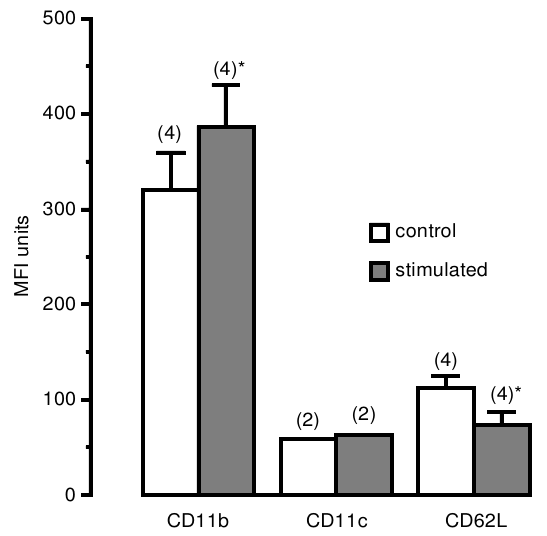
Table 1. Effect of DEX on basal CD11b and CD49d levels on human Eù s Adhesion molecule measured. Data are mean SEM of ( n ) experiments performed in duplicate. P , 0.05 when compared with control